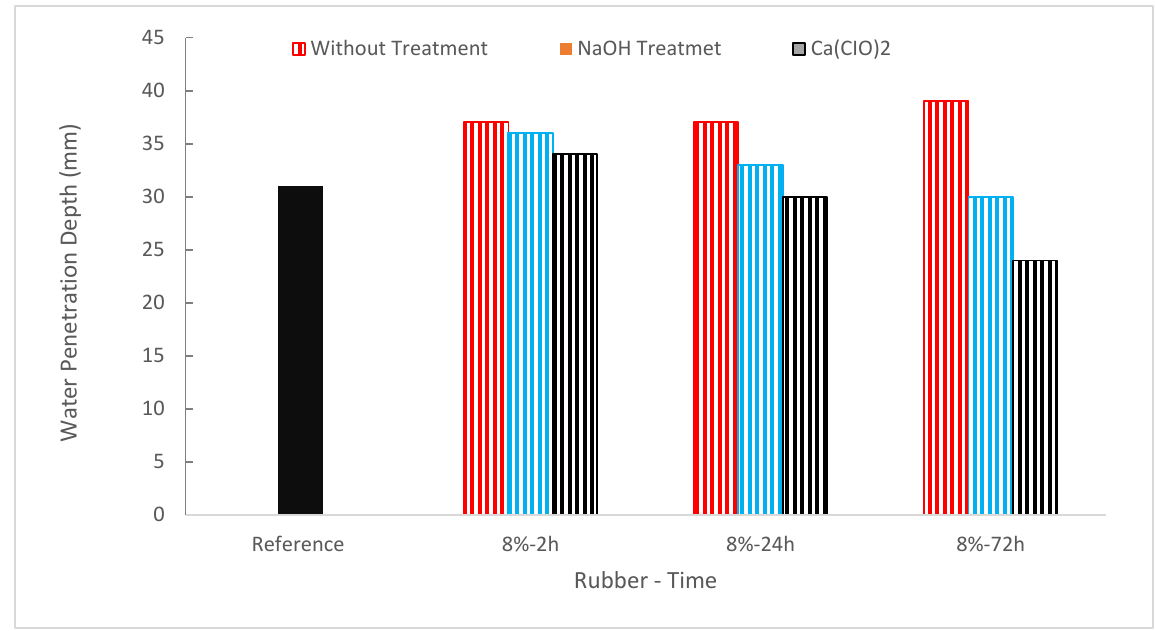
Figure 19. Water Penetration Depth: Data Source [39].